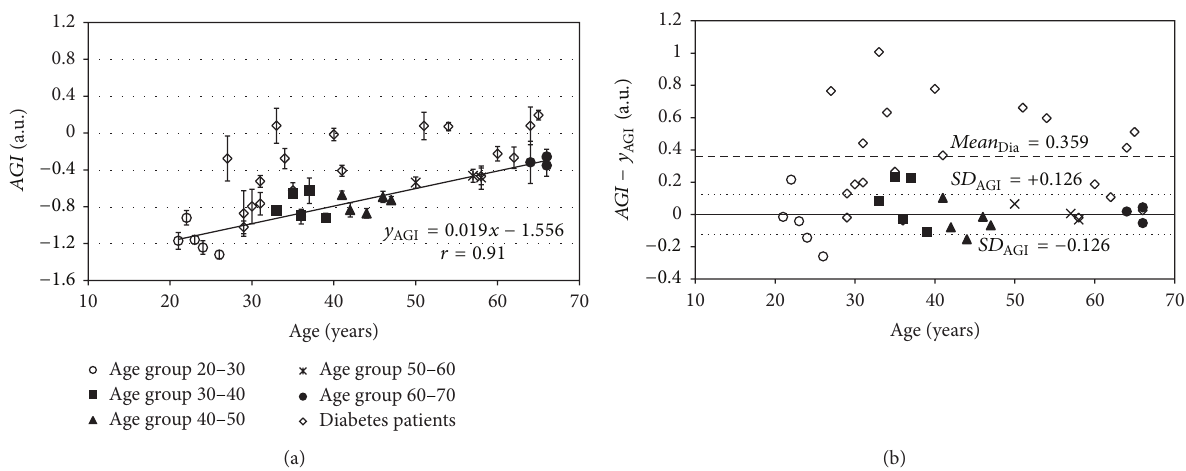
Figure 7: (a) The AGI data points with standard deviation ( SD ) bars for groups of healthy subjects and diabetes patients. The linear model is constructed for a group of healthy subjects. (b) Bland-Altman plot for constructed model. With dotted line the standard deviation line 𝑦 AGI levels for group of healthy subjects are given. With dashed line is given the mean AGI difference from linear model for diabetes